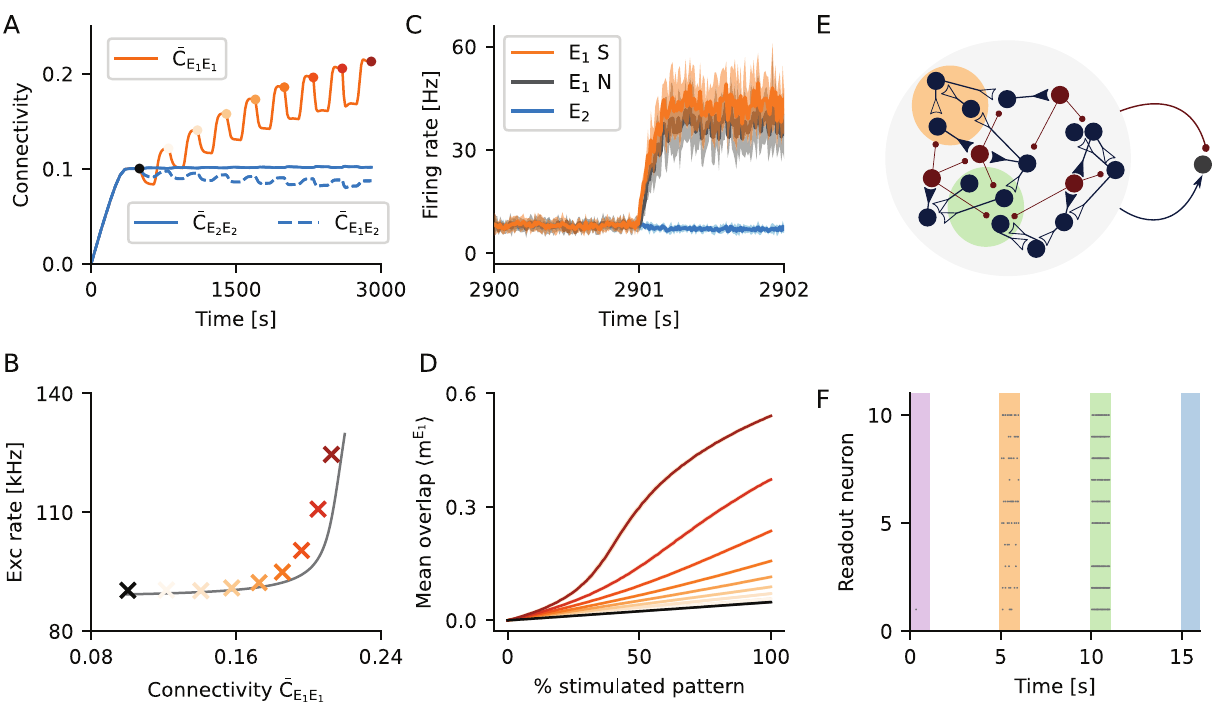
Fig 3. Evoked activity depended on the strength of a memory. (A) Starting from a random network grown under the influence of unstructured stimulation (black dot), we repeatedly stimulated the same ensemble of excitatory neurons E 1 to eventually form an engram. Multiple stimulation cycles increased the recurrent connectivity within the engram. (B) Population activity of all excitatory neurons upon stimulation of E 1 , for different levels of engram connectivity � C . Crosses depict the population rate observed in a simulation. Colors indicate engram connectivity � C , matching the colors E 1 E 1 E 1 E 1 used in panels (A) and (D). The grey line outlines the expectation from a simple mean-field theory. (C) Firing rate of E 1 engram neurons upon stimulation of 50% its neurons. Shown is the mean firing rate of the stimulated engram neurons ( E 1 S , orange), the mean firing rate of the non-stimulated engram neurons ( E 1 N , grey), and the mean firing rate of excitatory neurons not belonging to the engram ( E 2 , blue). Solid line and shading depict mean and standard deviation for 10 independent simulation runs, respectively. (D) Time-averaged overlap h m E 1 i , for different fractions of E 1 being stimulated. The recurrent nature of memory engrams enabled them to perform pattern completion. The degree of pattern completion depended monotonically on engram strength. (E) Two engrams (orange and green) were encoded in a network. Both engrams had a different strength with regard to their within- engram connectivity (green stronger than orange). A simple readout neuron received input from a random sample comprising 9% of all excitatory and 9% of all inhibitory neurons in the network. (F) Raster plot for the activity of 10 different readout neurons during the stimulation of learned engrams and random ensembles, respectively. Readout neurons were active when an encoded engram was stimulated (orange and green), and they generally responded with higher firing rates for stronger engrams (green). The activity of a readout neuron was low in absence of a stimulus (white), or upon stimulation of a random ensemble of neurons (purple and